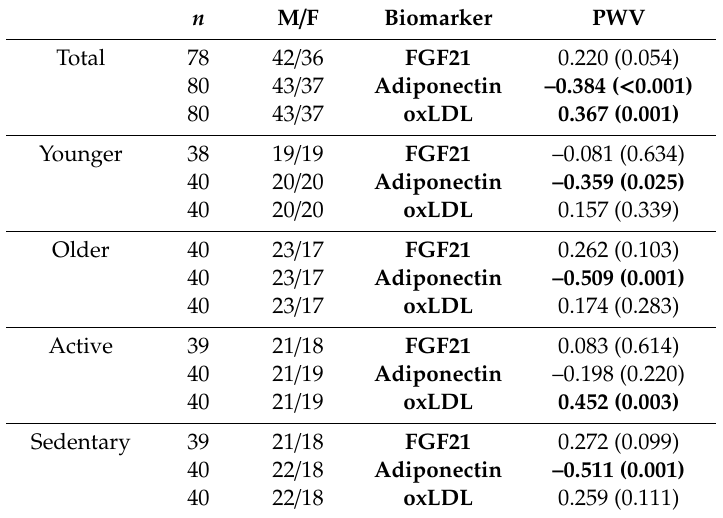
Table 2. Pearson’s correlations ( r ) between FGF21, adiponectin, oxLDL and pulse wave velocity